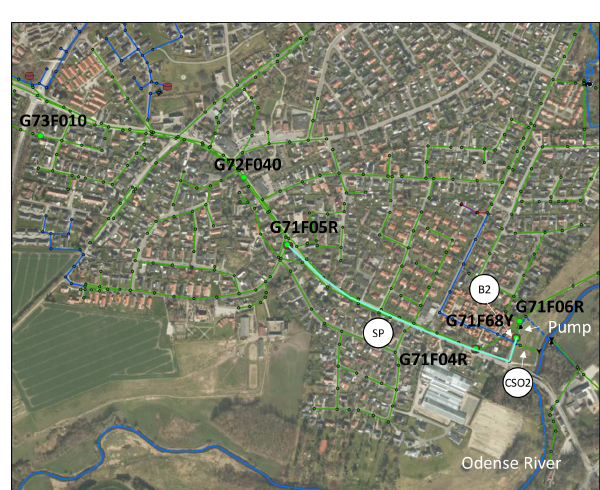
Figure 6. Location of the sensors in Bellinge. The storage pipe (SP) and basin B2 are highlighted (cyan), and the location of CSO2 is indicated. Background maps provided by DADSE